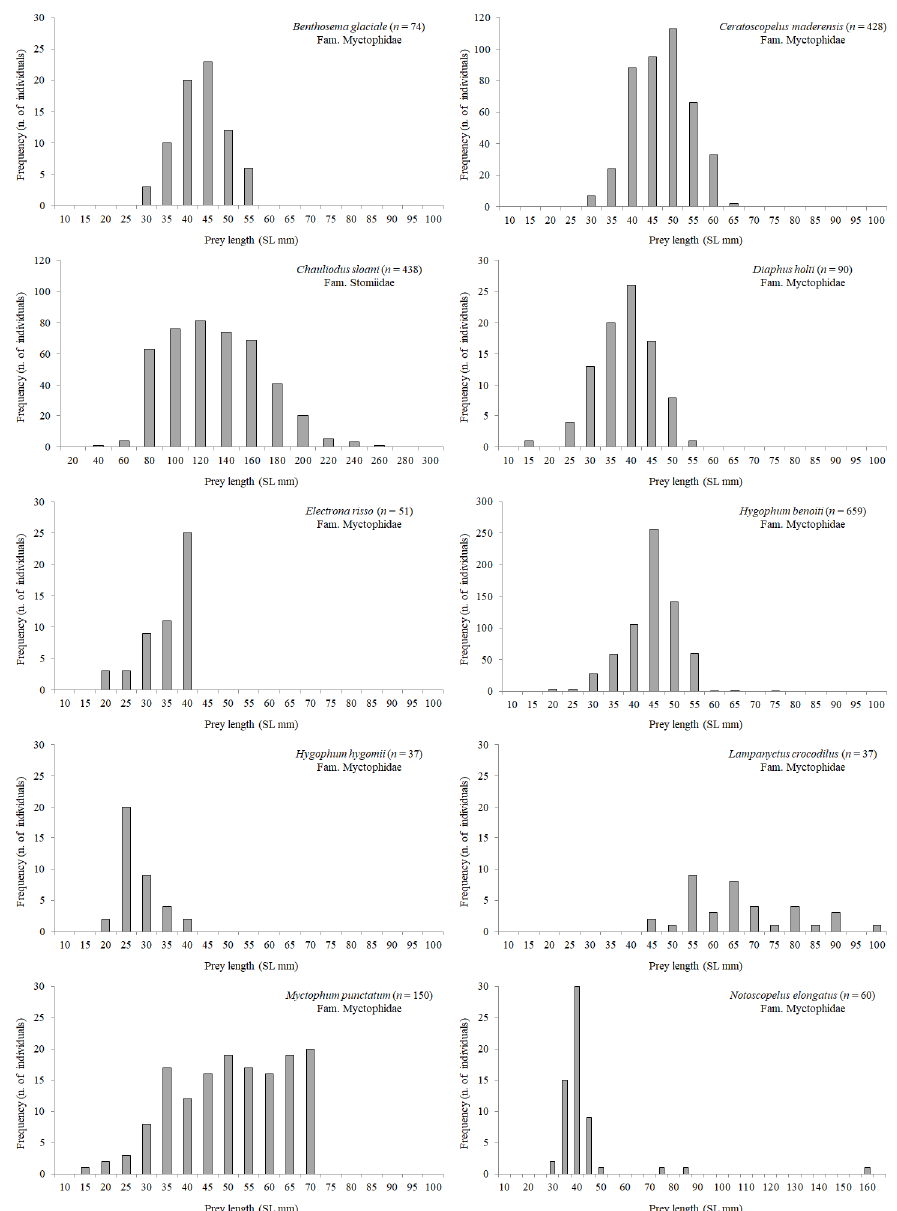
Figure 5. Length frequency distribution of the most abundant mesopelagic fish prey found in BFT stomachs in the Strait of Messina. Given the variability among species in size range and number of individuals, graphs do not report the same scale in x ‐ and y ‐ axes.